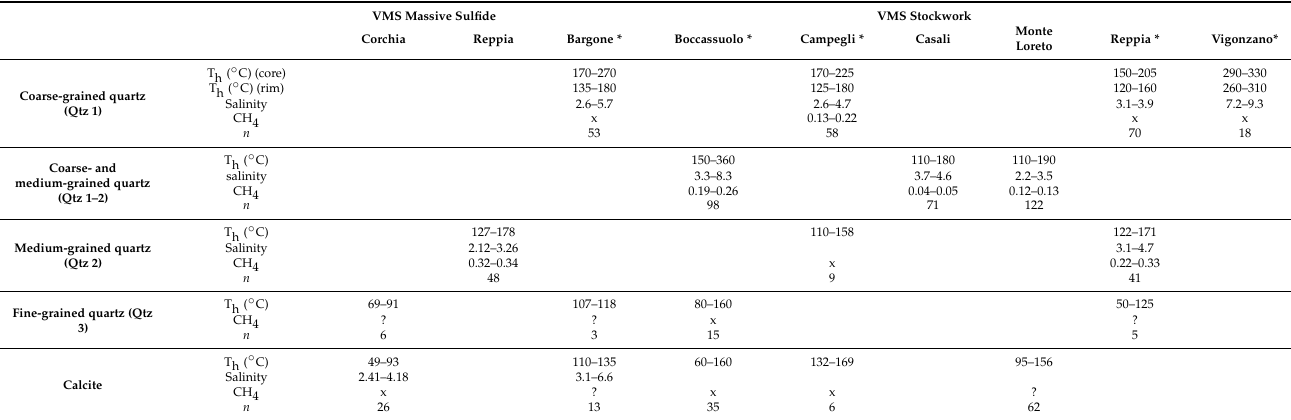
Table A1. Summary of primary fluid inclusion